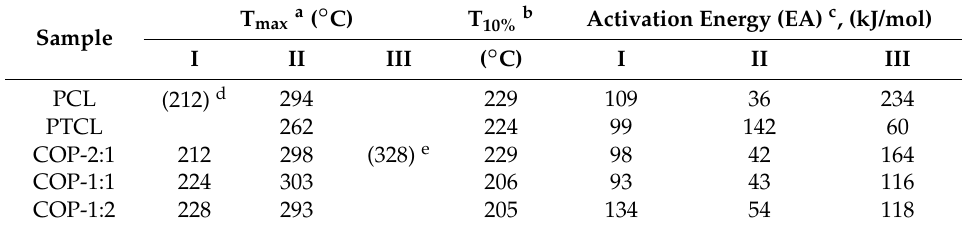
Table 2. Main Thermogravimetric analysis (TGA) results of homo- and copolymers of CL and TCL.